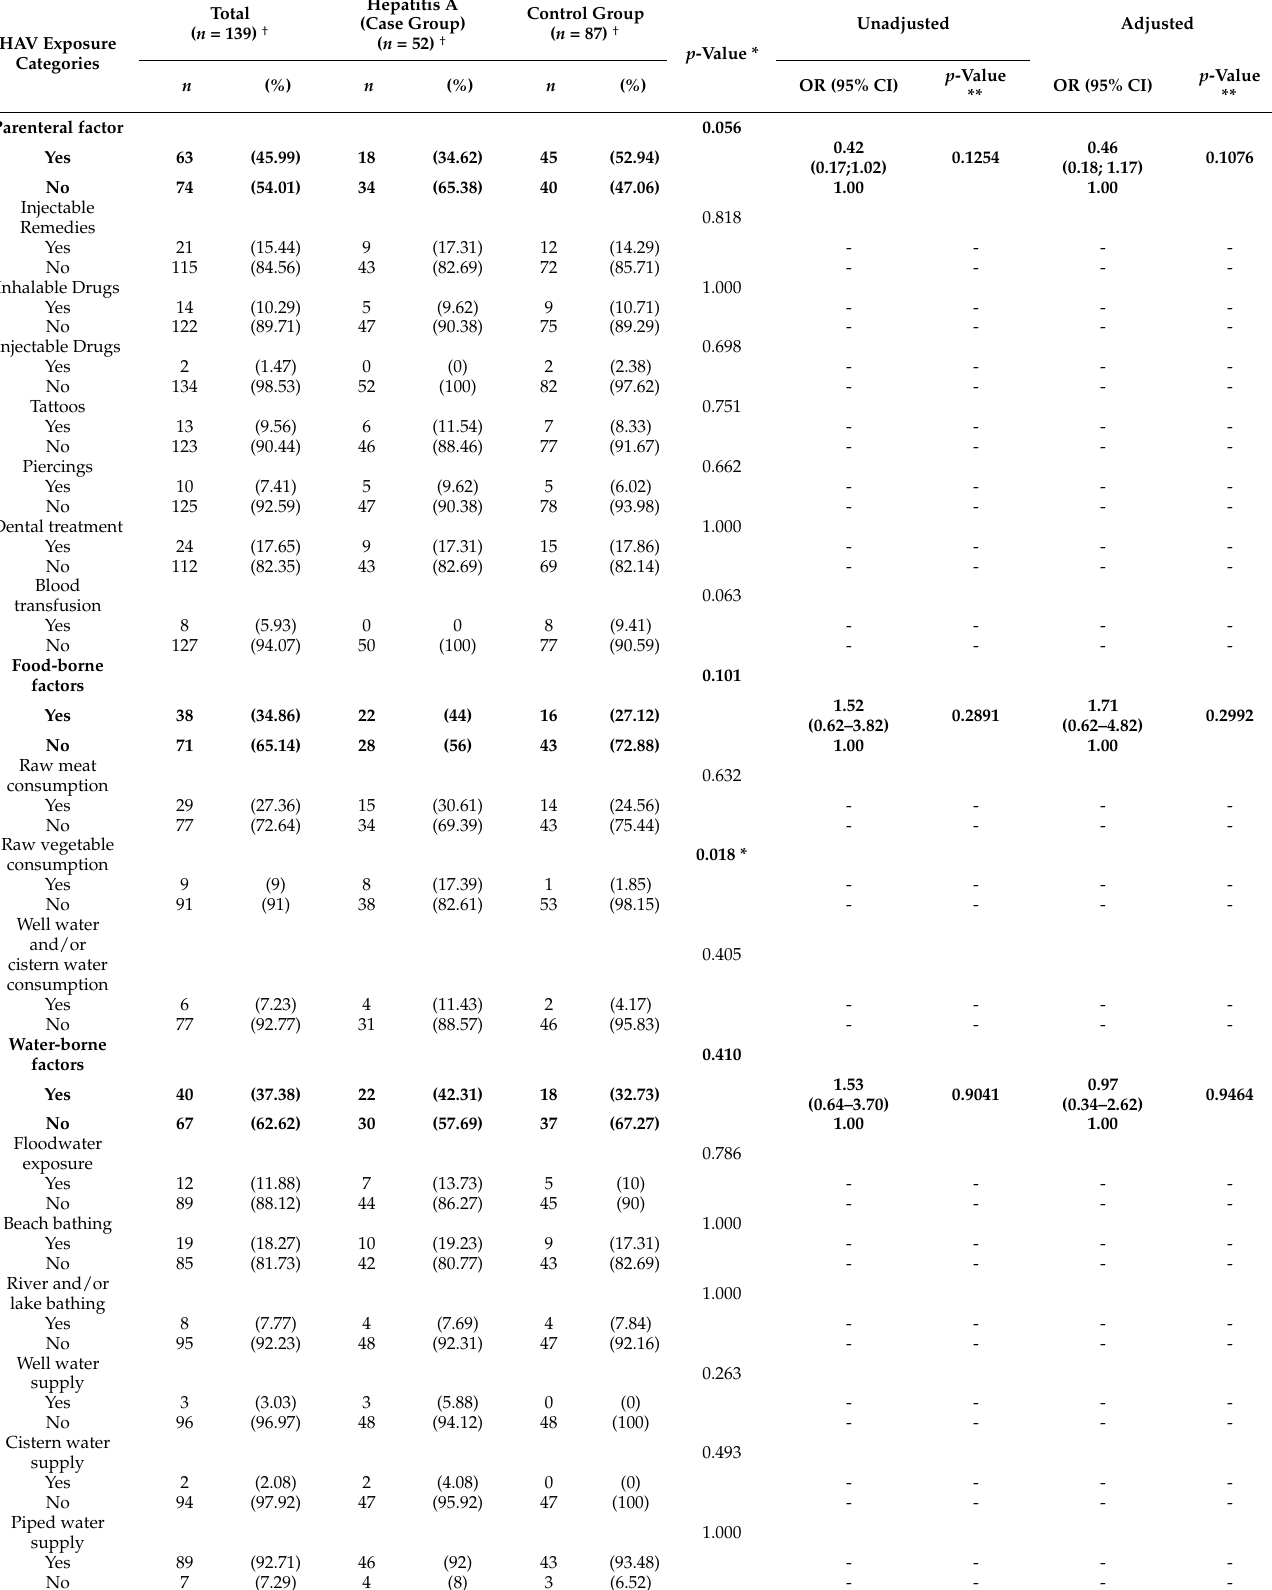
Table 2. Patients’ socio-behavioral characteristics: HAV exposure